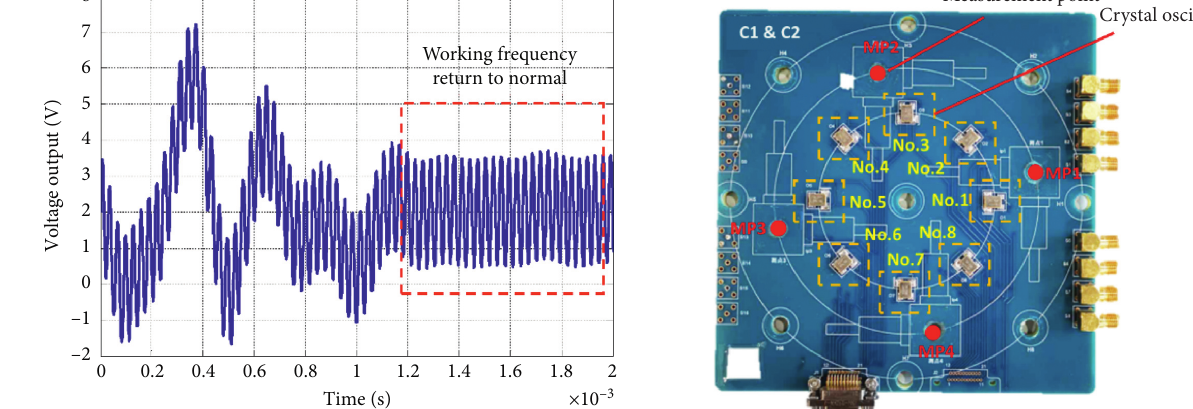
Figure 7: Crystal oscillators distributed on the PCB.